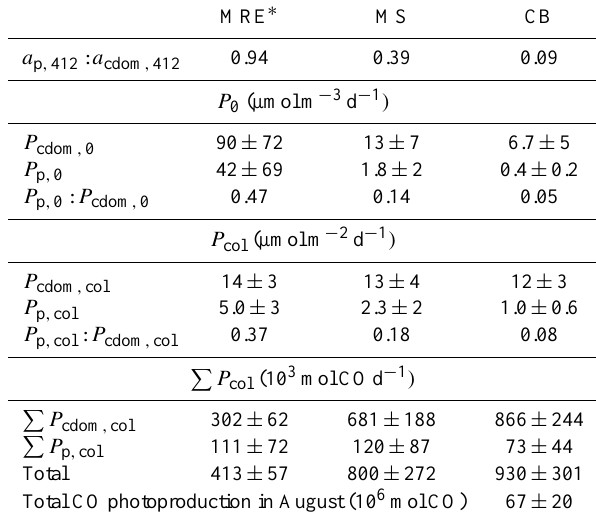
a p , 412 : a cdom , 412 in August 2009 based on individual stations within each sub-region. Keys for MS and CB are the same as those in Table